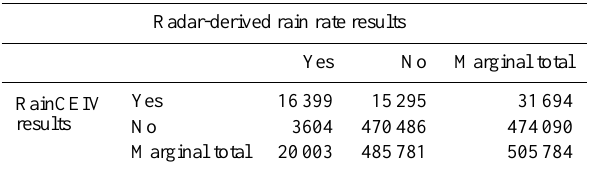
Table 10. Contingency table for the dichotomous statistical assess- ment of the RainCEIV algorithm for all the pixels used for nighttime validation.